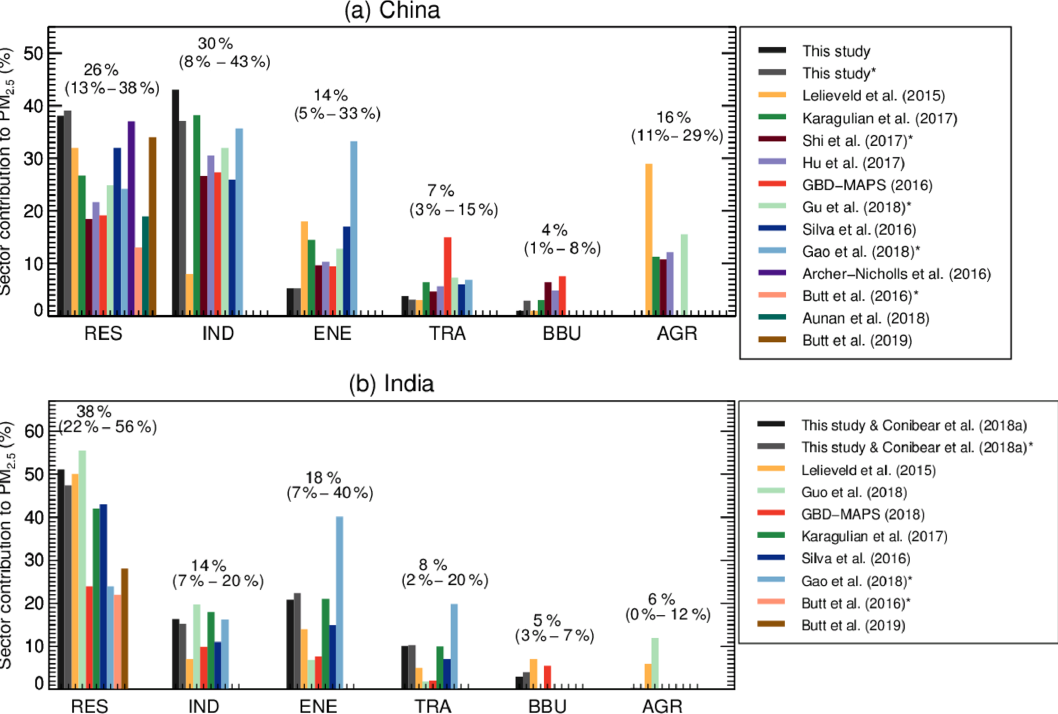
Figure 7. Comparison of relative sector-specific contributions to annual mean PM 2 . 5 concentrations in (a) China and (b) India from this study and previous studies. Bars show sector contributions to population-weighted annual mean PM 2 . 5 concentrations, with the exception of the bars associated with studies shown in the legend with an asterisk ( ∗ ), which show estimated sector contributions to surface area-weighted annual mean PM 2 . 5 concentrations. In our study, population-weighted and area-weighted values differ by less than six percentage points. The mean relative contribution of each sector is shown above the bars with the range of values (minimum to maximum) in parentheses. The values for each study are also shown in Tables 4 and 5. The emission sectors are agriculture (AGR), power generation (ENE), industrial non-power (IND), residential energy use (RES), land transport (TRA), and open biomass burning (BBU). We note that the contribution of the agricultural section to PM 2 . 5 is not quantified for China in this